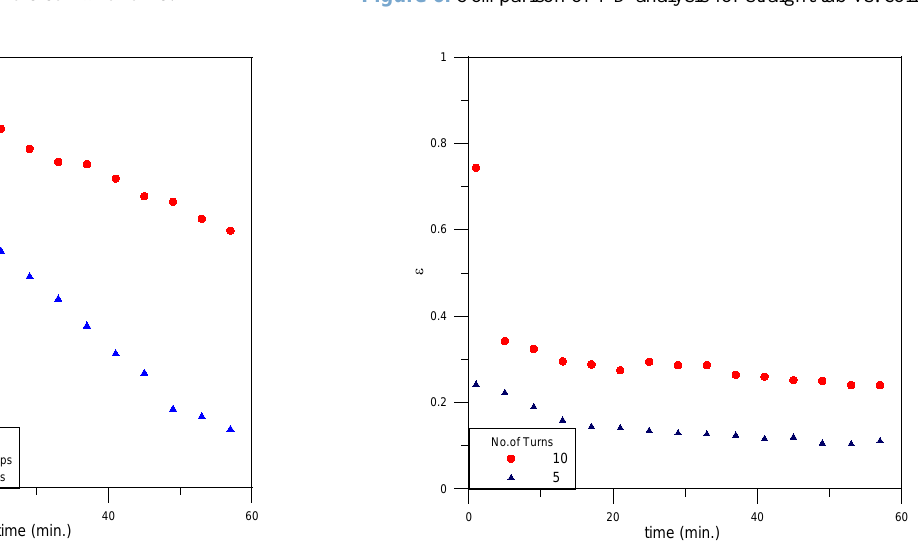
Figure 6. Comparison of 1-D analysis for straight tub vs. coil.